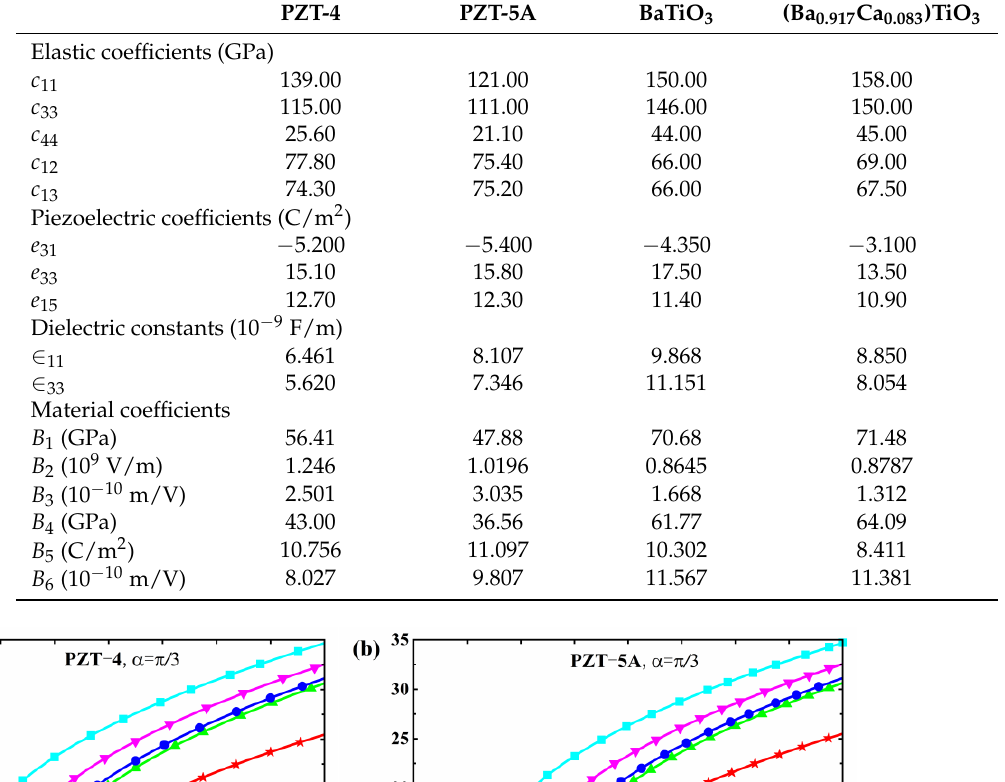
Table 1. Material constants of the four piezoelectric materials.